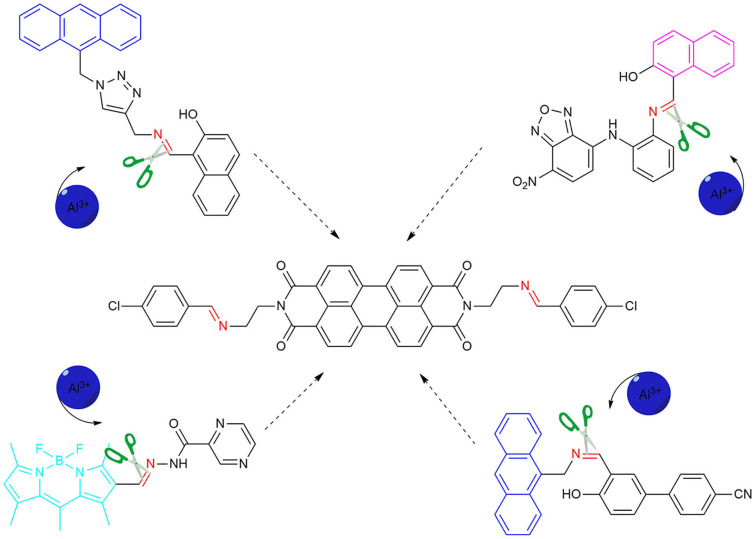
The design of the fluorescent probe PCN for Al3+.